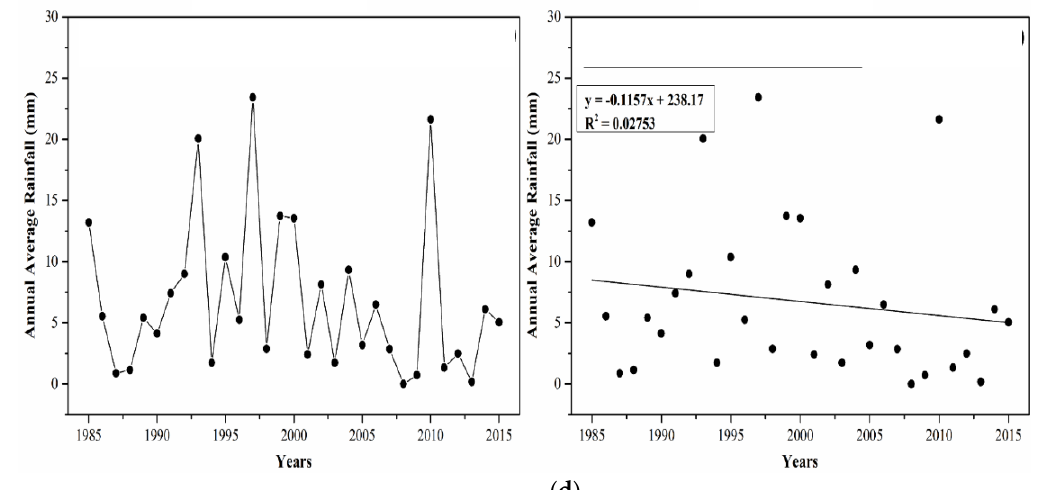
Figure 3. Changes in annual ( a ) maximum, ( b ) minimum and ( c ) average temperatures and ( d ) precipitation across years.